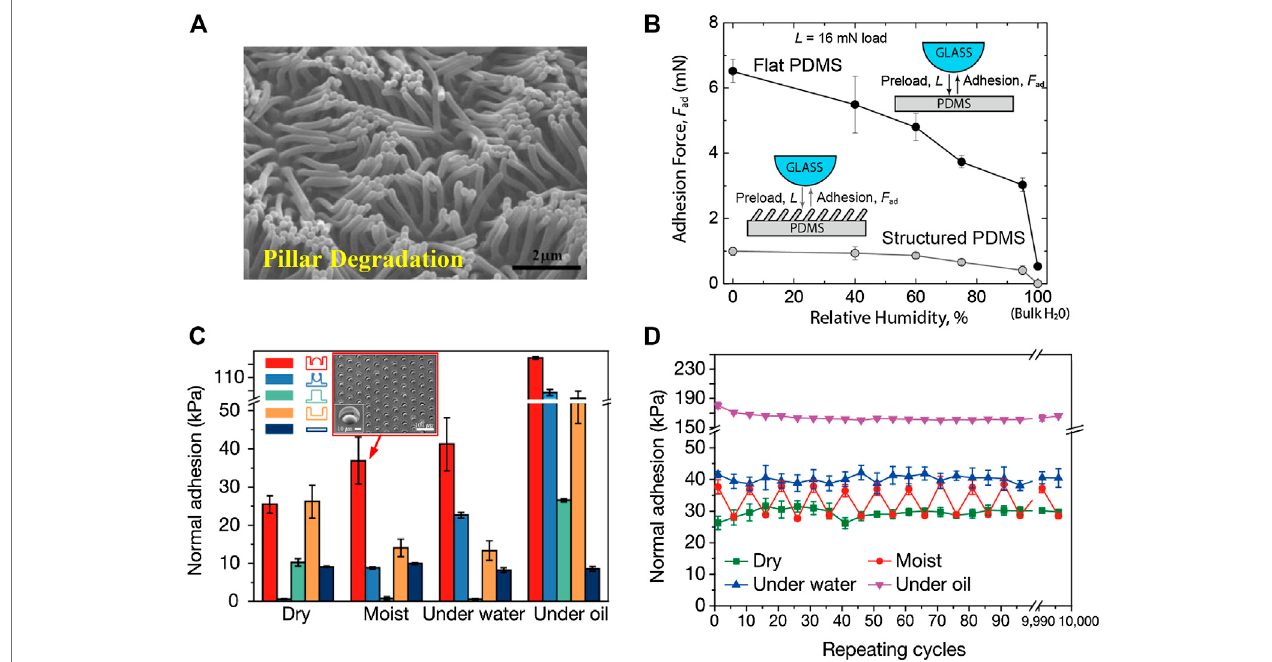
FIGURE2 | Limitationsof pillared surfaces and advantages ofcratered surfaces asSDAs. (A) Ascanning electron microscopy (SEM) image ofpillar condensation. (reprinted with permission from ref (Kim et al., 2007)). (B) Adhesion force of micro-pillars as a function of relative humidity (reprinted with permission from ref (Cadirov et al., 2017)). (C) Adhesive strengths of various pillared and cratered structures where red: protuberance-shaped crater; blue: perforated cylinders; green: cylindrical pillar; brown: cylindrical hole; black: fl at surface (reprinted with permission from ref (Baik et al., 2017)). (D) Repeatable adhesion of the crater-enabled SDAs after more than 10000 cycles of attachment and detachment (reprinted with permission from ref (Baik et al., 2017)).